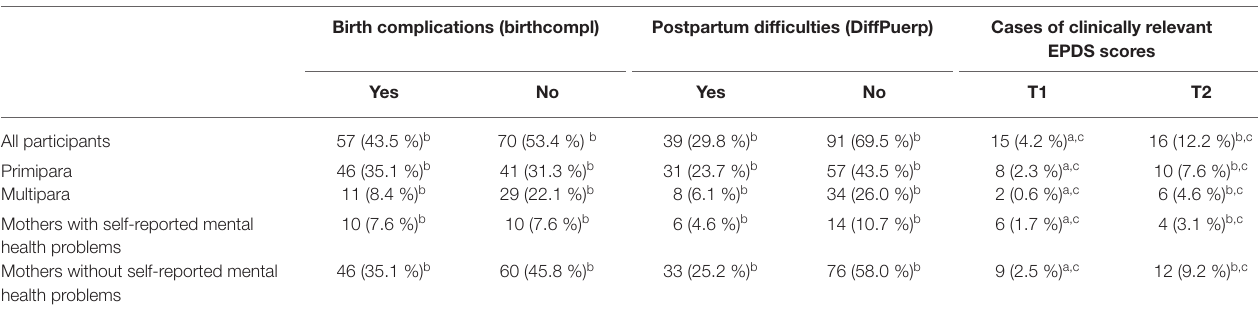
TABLE 2 | Descriptive Data of categorically scaled